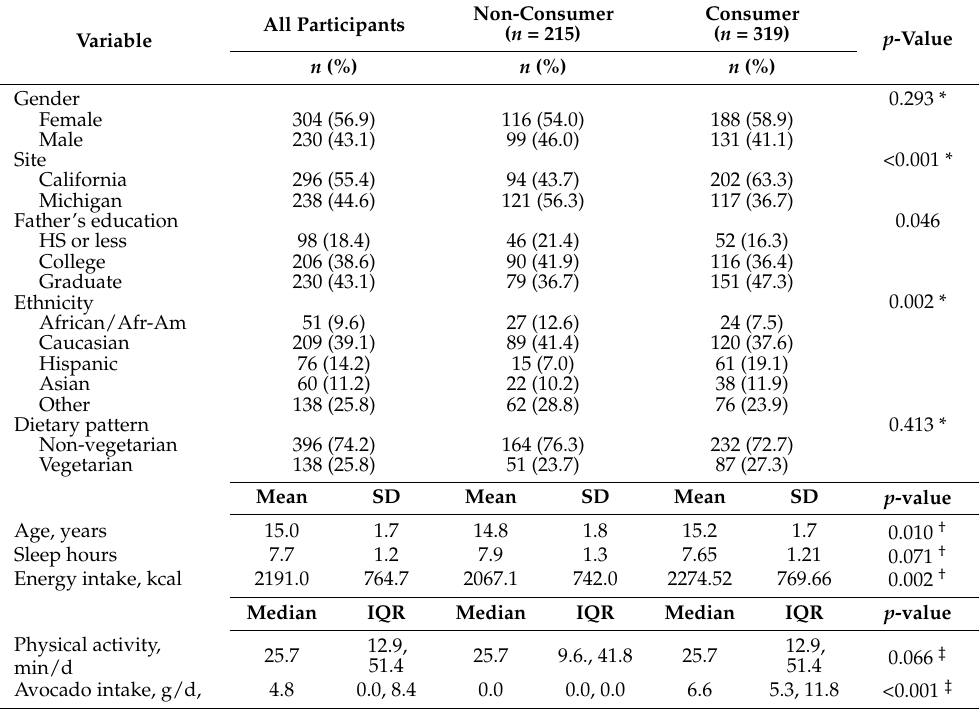
Table 2. Characteristics of the study population, all participants and according to avocado intake.